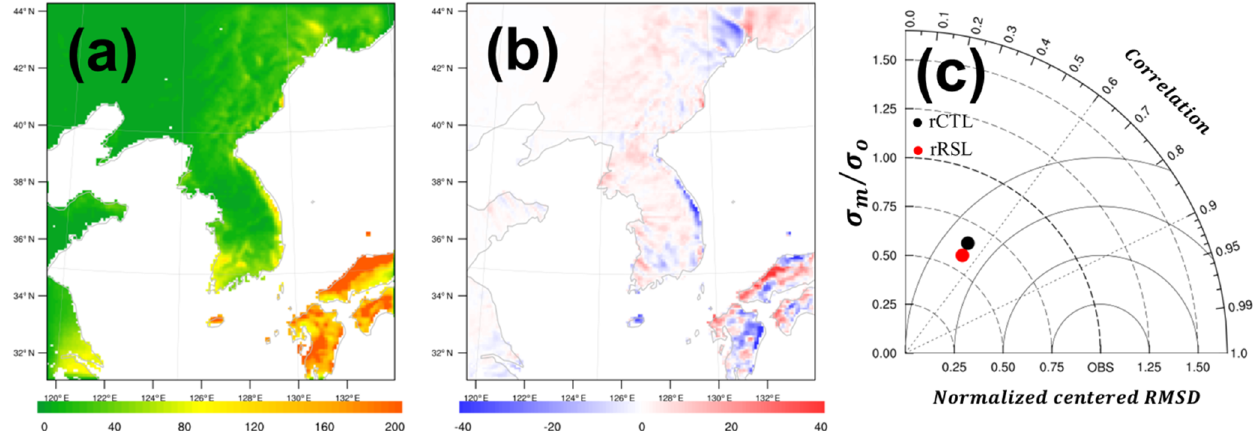
Figure 13. (a) The 1-month accumulated precipitation of the rCTL experiment (mm) and (b) difference (rRSL–rCTL). (c) Taylor diagram showing the correlation coefficient, normalized centered RMSD, and the standard deviations of models ( σ m ) normalized by that of the observation ( σ o ) and from the rain rate (mmh − 1 ) of the rCTL experiment (black) and the rRSL experiment (red) during 1 month at 656 rain